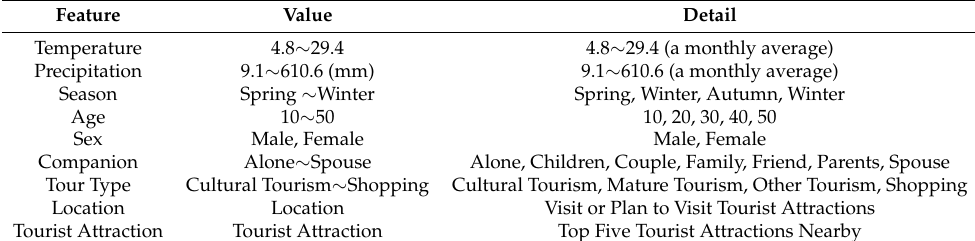
Table 3. Input and output feature values and details of R2Tour.